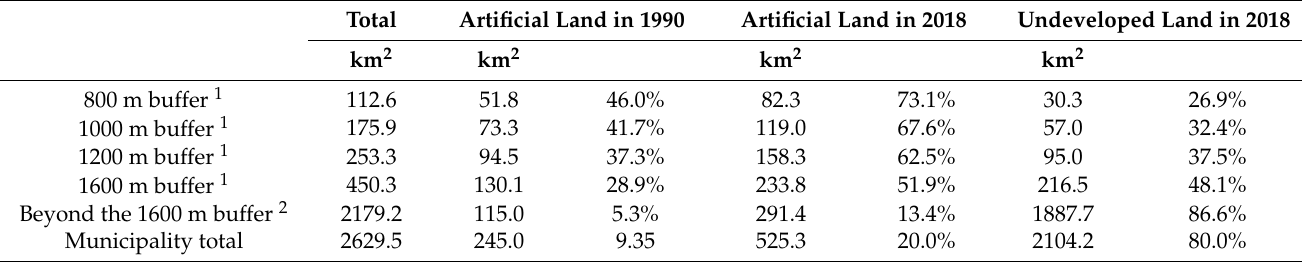
Table 6. Artificial land (km 2 ) in 1990 and 2018 around commuter railway stations in the Madrid urban region. Source: CORINE Land Cover—National Geographic Information Centre.